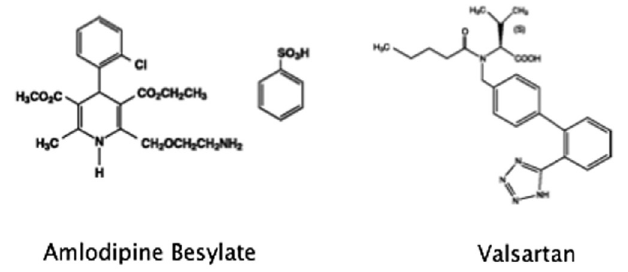
FIGURE 1 - The chemical structures of amlodipine besylate and